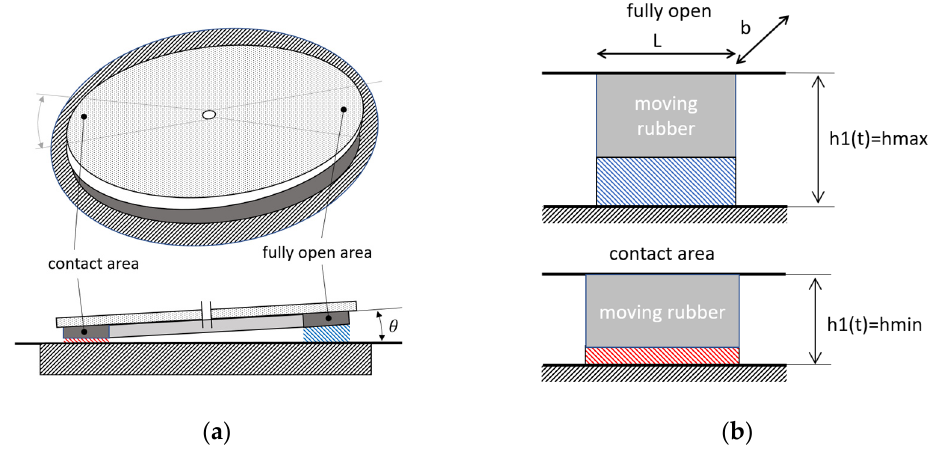
Figure 7. Analogous model of the complex pump system regarding the dynamic film on the contact area: ( a ) illustration of the simplified wobble situation; ( b ) principal abstracted scheme.